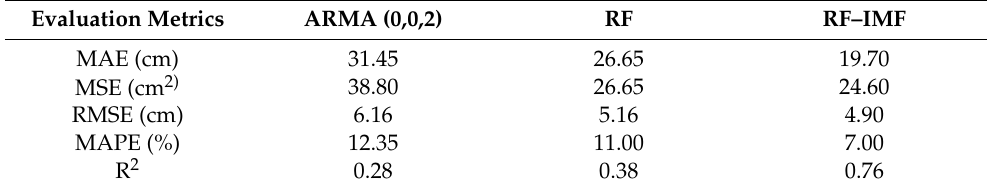
Table 3. Comparison of different prediction models using Evaluation